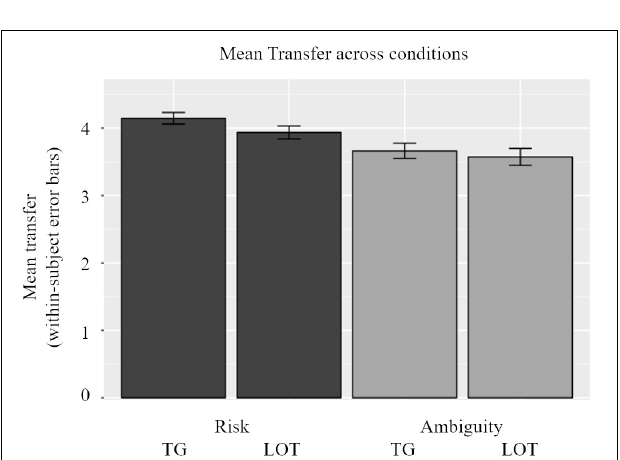
FIGURE 4 | Overview of transfer choices across conditions. Participants invest less in the ambiguous conditions [both in Trust Game (TG) and lottery (LOT)] than the risky conditions. This effect is highly influenced by beliefs. The general pattern of ambiguity aversion only holds for participants with low beliefs in trustees (and number of winning colors). There was no effect of sources of uncertainty: participants do not alter their transfer between the TG and the